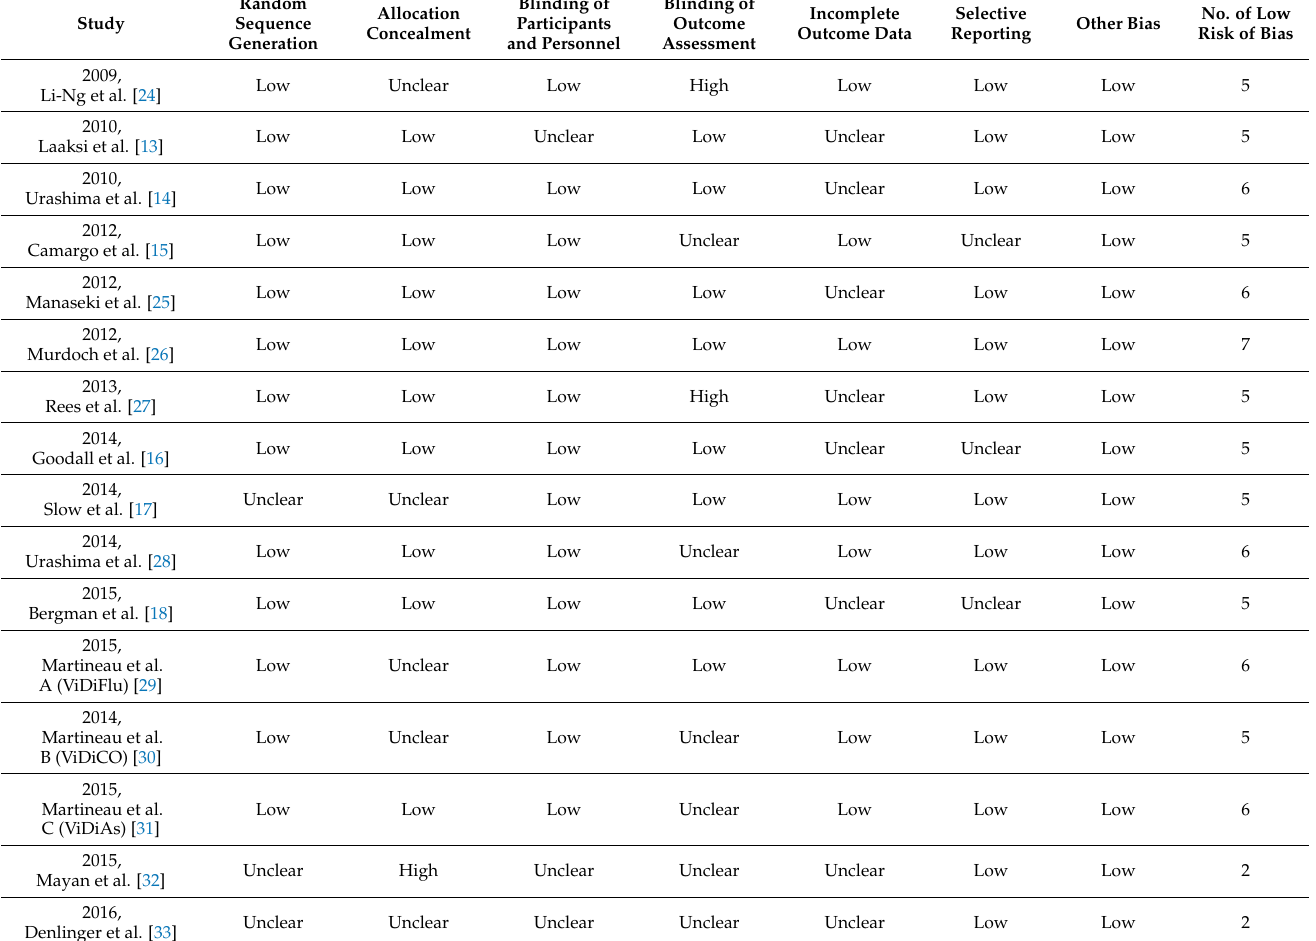
Table 3. Methodological quality of trials based on the Cochrane risk of bias tool ( n =